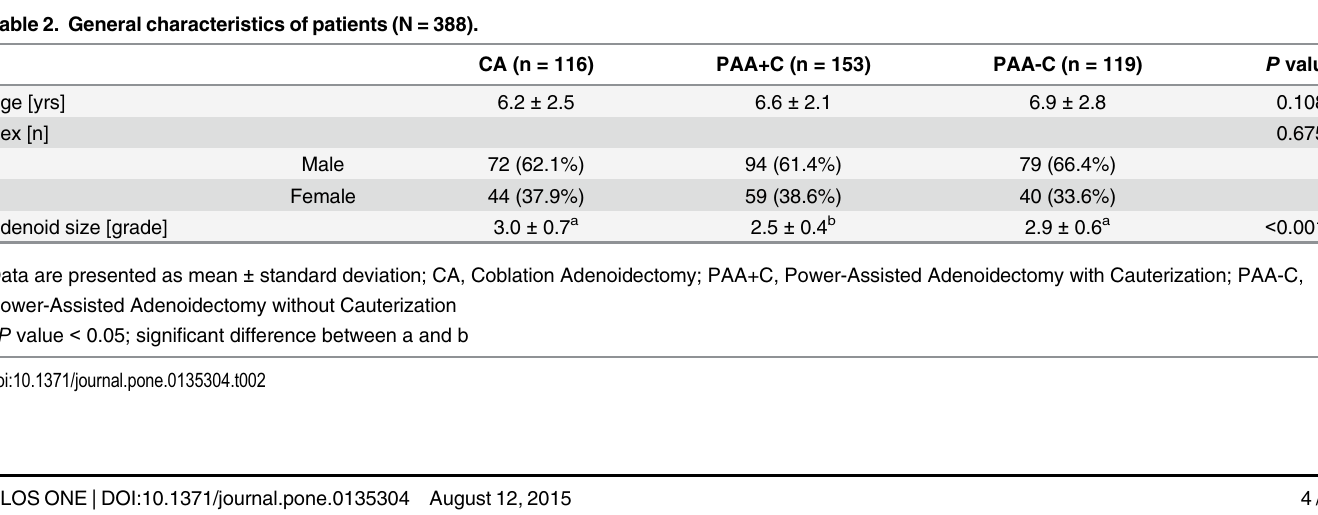
Table 2. General characteristics of patients (N = 388).